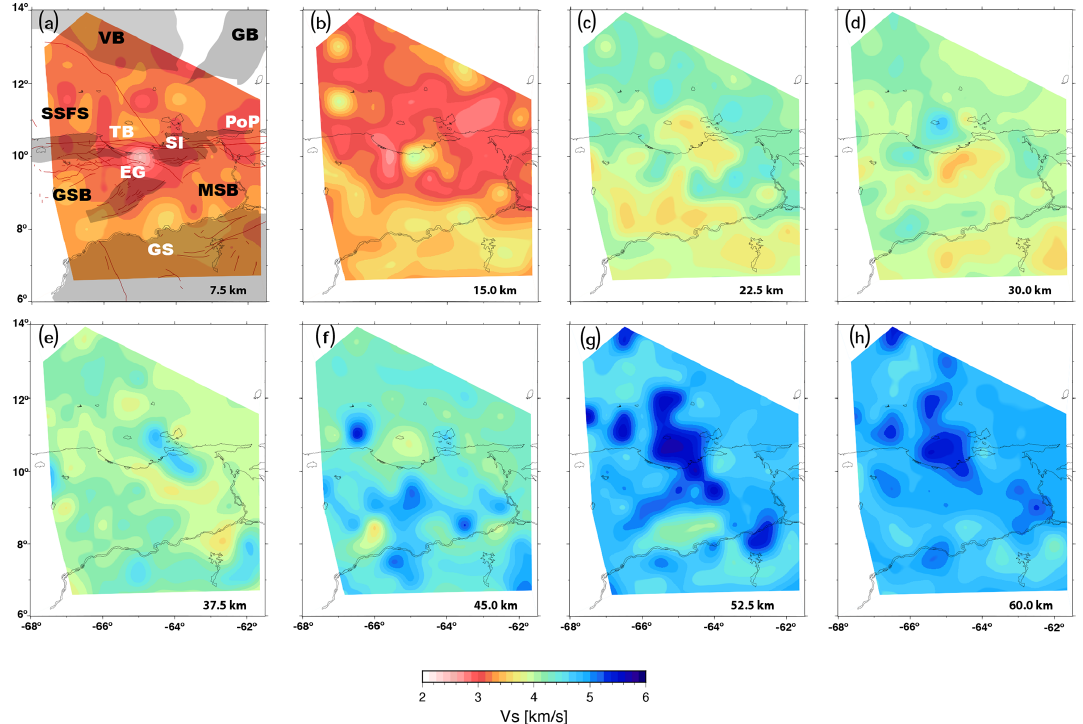
Figure 10. Horizontal slices of the 3D shear-wave velocity model obtained in this study. (a–h) Increasing depth in steps of 7.5km until 60km depth. In red we show active faults as presented by Audemard et al. (2006). Abbreviations are VB (Venezuela Basin), GS (Guiana Shield), MSB (Maturín sub-basin), GSB (Guarico sub-basin), SI (Serrania del Interior), EG (Espino Graben), TB (Turtle Island–Barcelona Bay), PoP (Peninsula of Paria) and SSFS (San Sebastian Fault System). VB, GB, SSFS, EG, SI, PoP and GS regions are highlighted with shaded